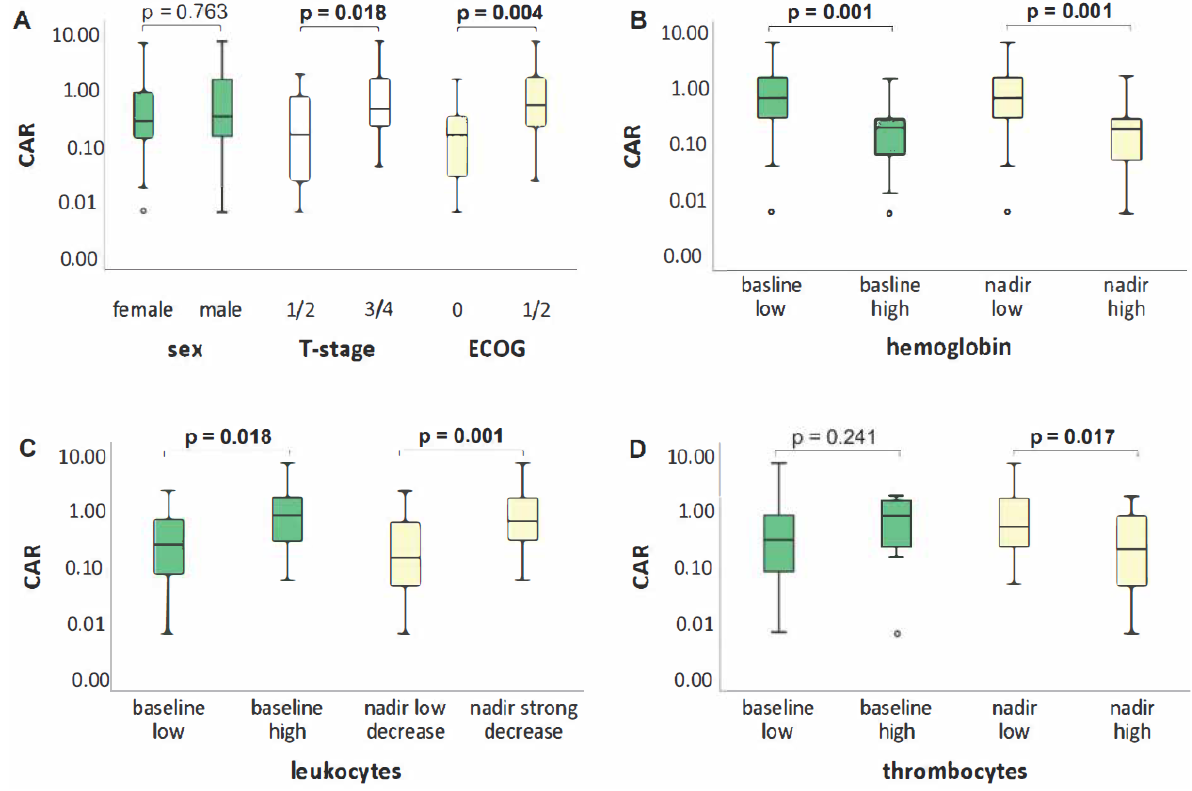
Figure 1. Differences in CAR by sex, T-stage, ECOG ( A ) and blood count (hemoglobin ( B ). leukocytes ( C ) and thrombocytes ( D ).